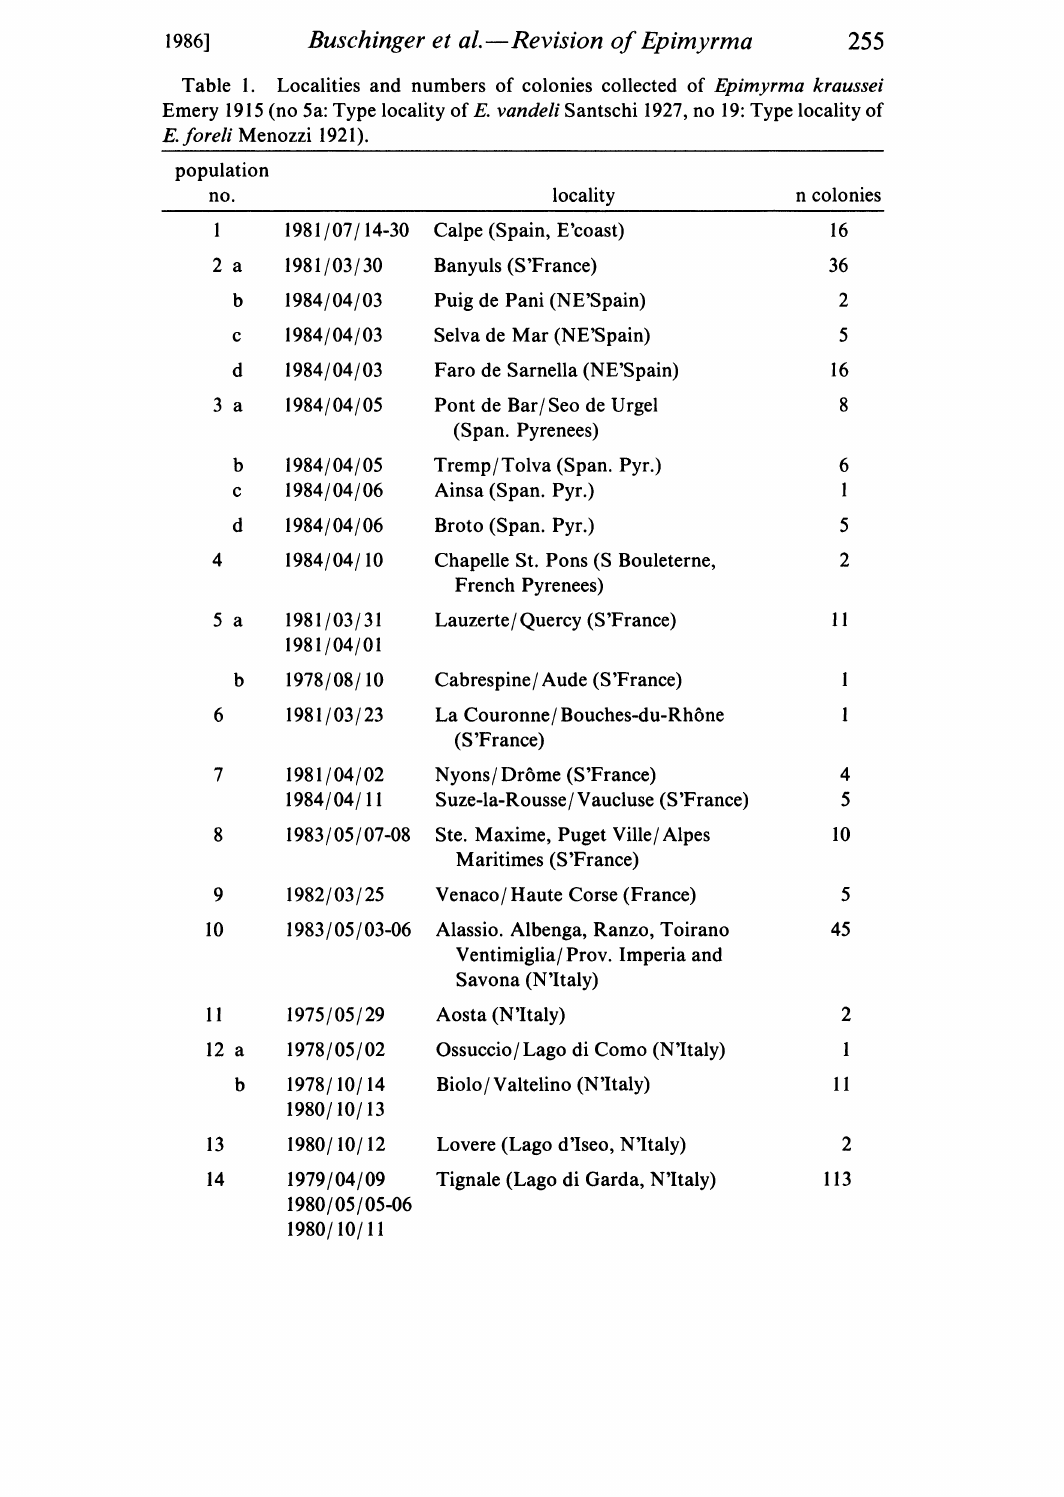
Table 1. Localities and numbers of colonies collected of Epimyrma kraussei Emery 1915 (no 5a: Type locality of E. vandeli Santschi 1927, no 19: Type locality of E. foreli Menozzi